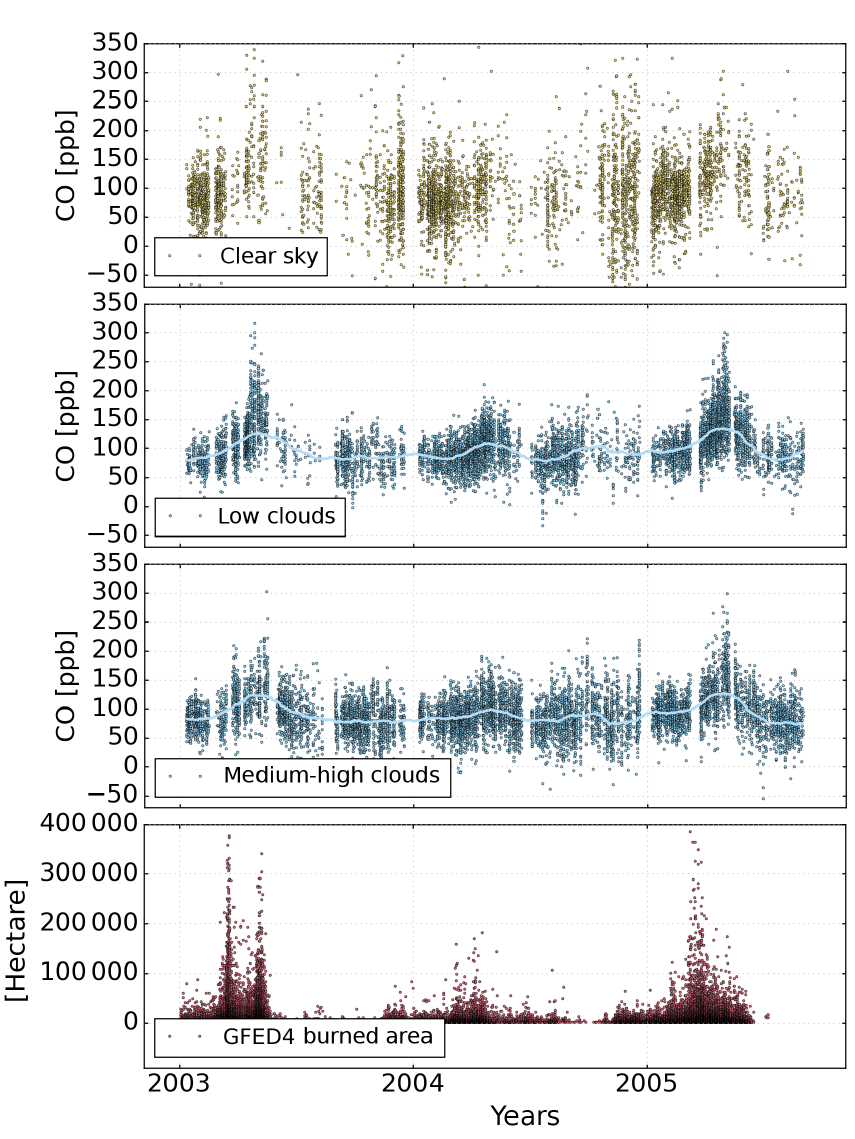
Figure 2. Individual SCIAMACHY CO retrievals under clear-sky, low cloud and medium–high-cloud atmospheric conditions as well as daily GFED4 Burned Area over Mexico–Guatemala in the latitude–longitude box (22.5 ◦ N, 100.0 ◦ W; 10.0 ◦ N, 80.0 ◦ W). The blue line is a running median with a half width of 30